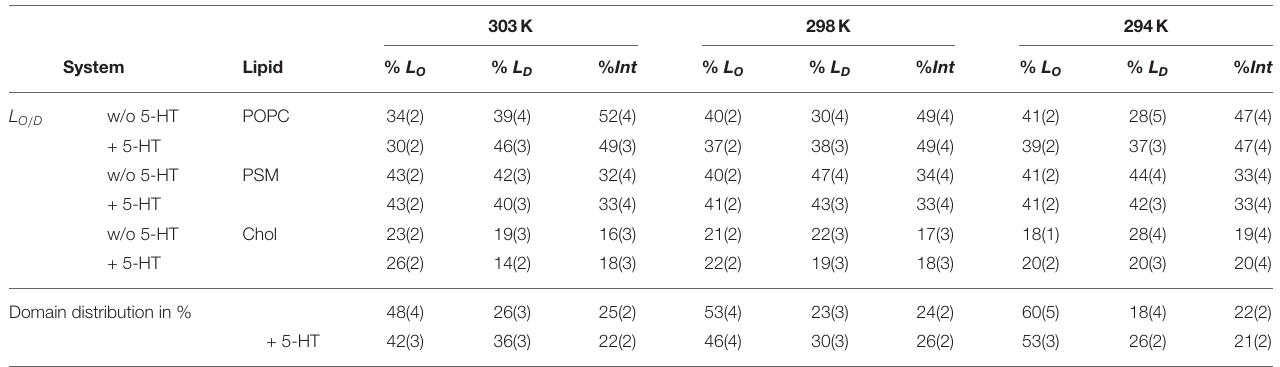
TABLE 3 | Phase distribution for Chol, POPC, and PSM lipids in the L O / D system. Standard errors are given in parenthesis. 303K 298K